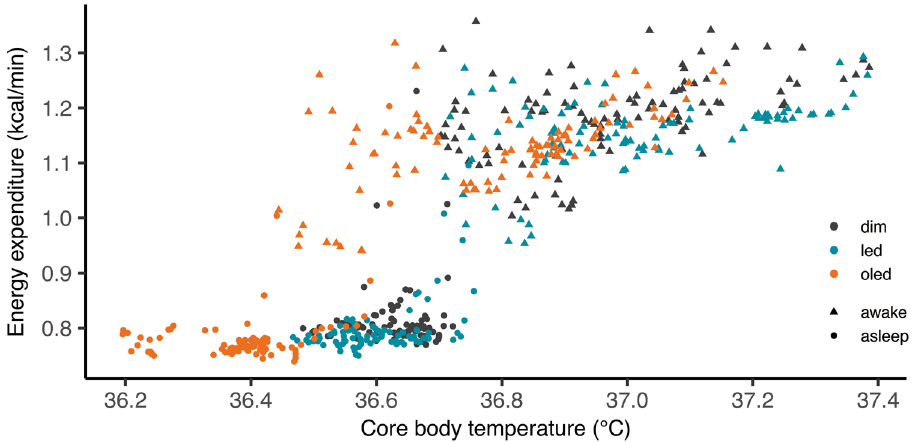
Figure 3. Correlation between core body temperature and energy expenditure. Correlation plotted as 5-min mean during sleep (circle) and wake (triangle) for dim (black), LED (blue), and OLED (orange) conditions.